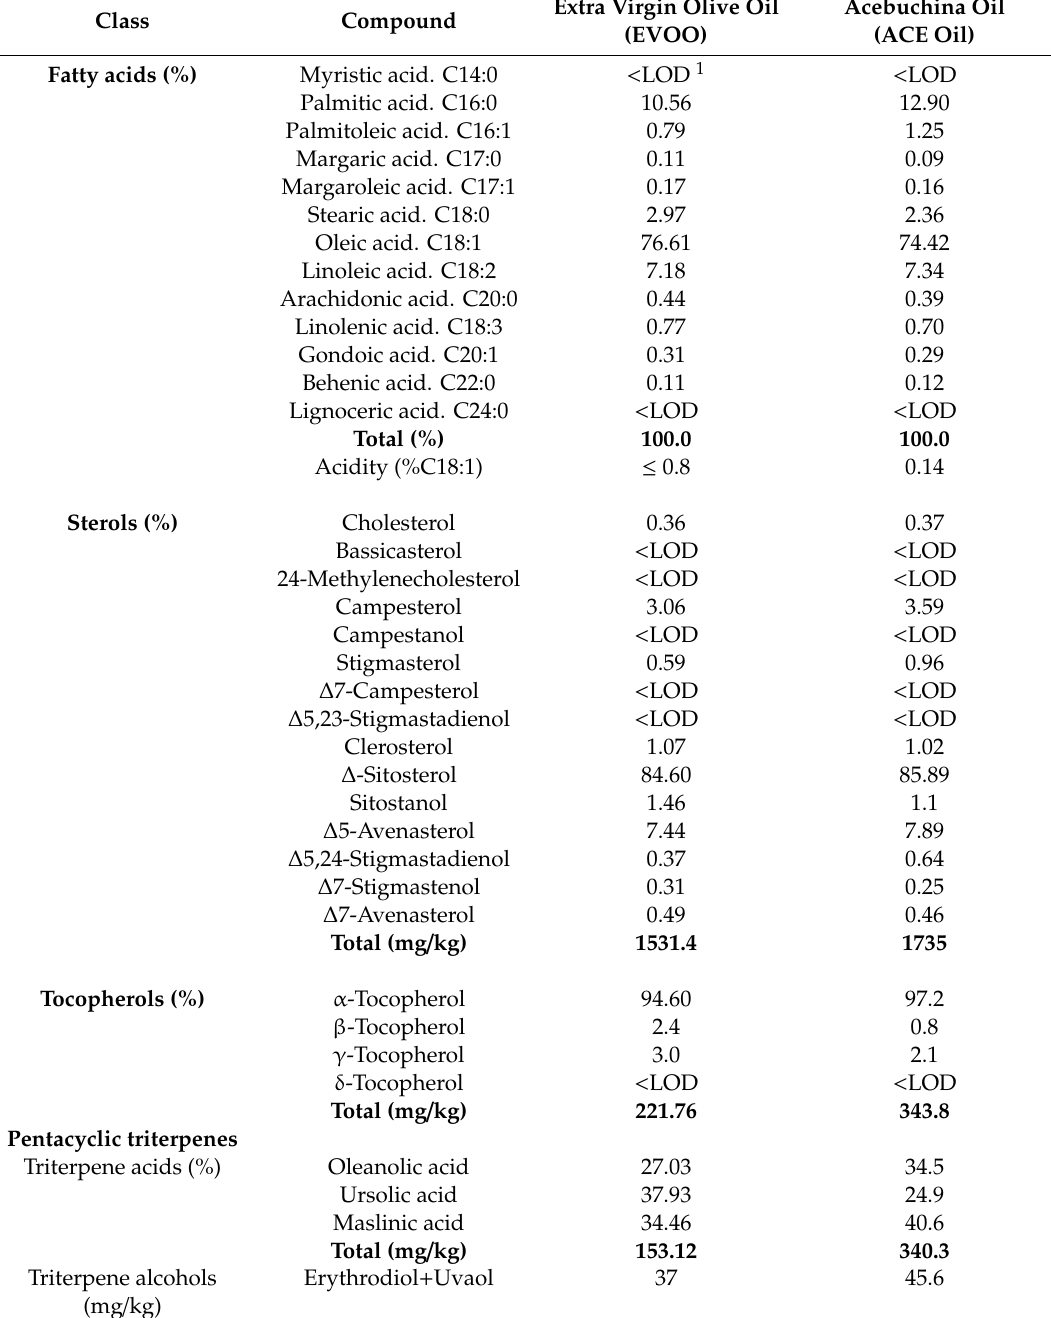
Table 1. Content of fatty acids, sterols, tocopherols, pentacyclic triterpenes and polyphenols in extra virgin olive oil (EVOO) and acebuche (ACE)